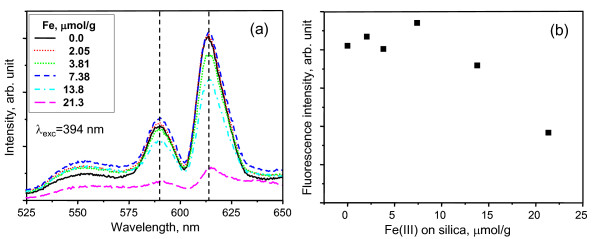
Fluorescence spectra and intensities of Eu(III) on partially Fe(III)-coated silica. (a) Fluorescence spectra (λexc = 394 nm), and (b) fluorescence intensities (λexc = 394 nm) of Eu(III) on partially Fe(III)-coated silica at 613 nm, according to the amount of coated Fe(III) at pH 7.